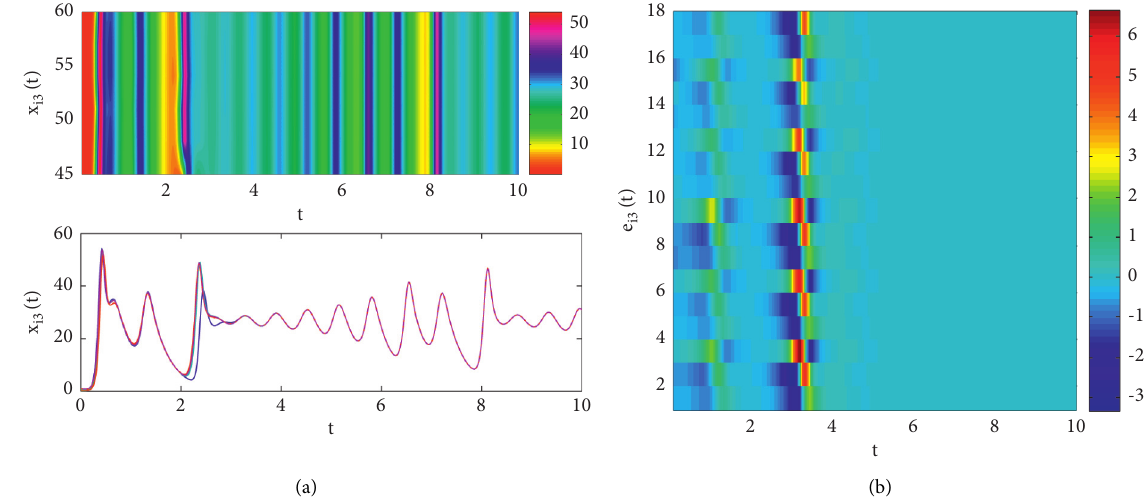
Figure 8: The evolution of state variables and the synchronization error in the third area.